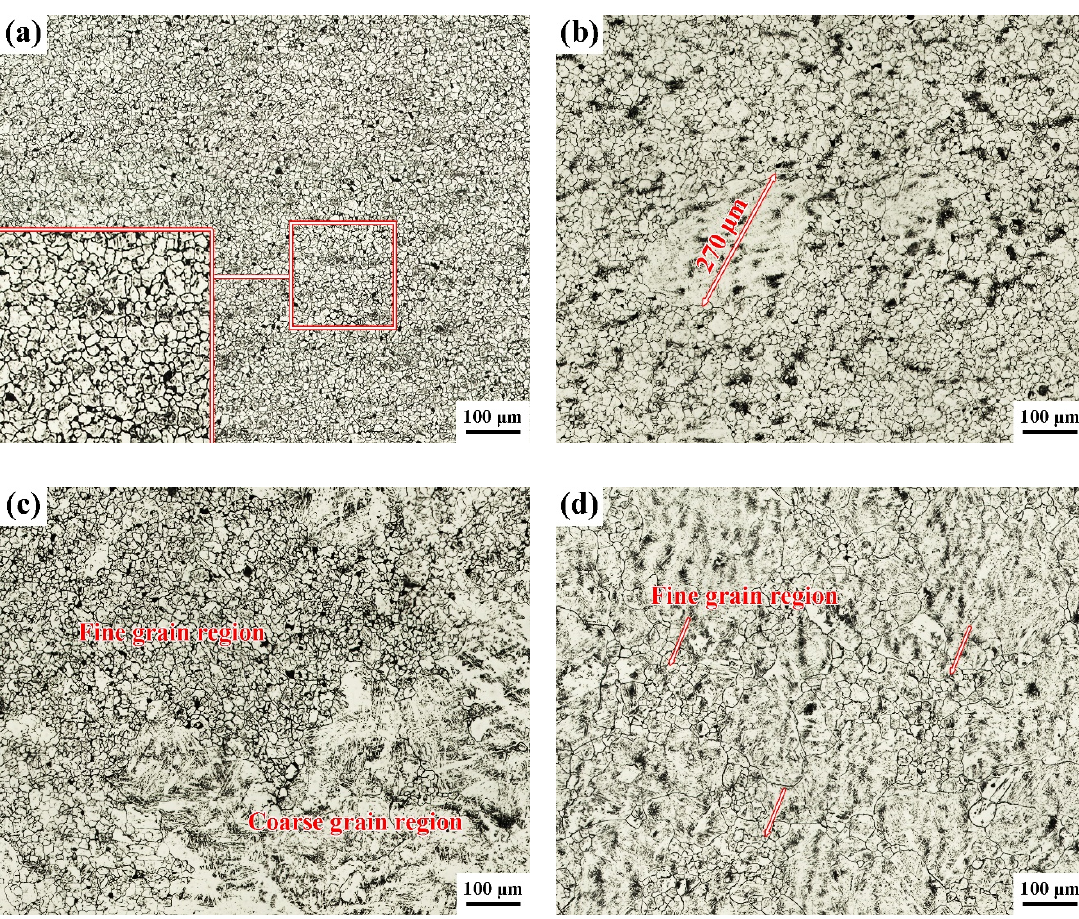
◦ C of ( a ) S2, ( b ) S4, ( c ) S5, and ( d )